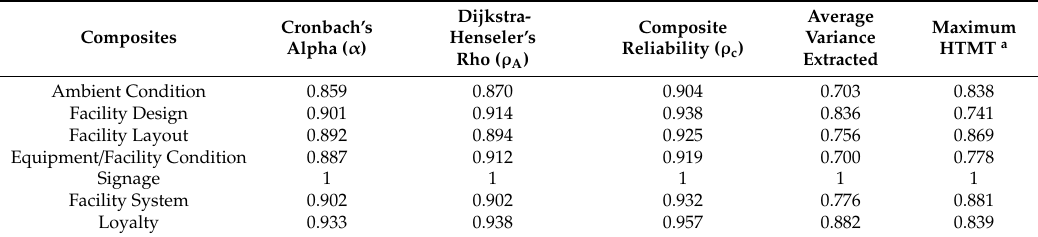
Table 4. Reliability and validity of construct measurement.